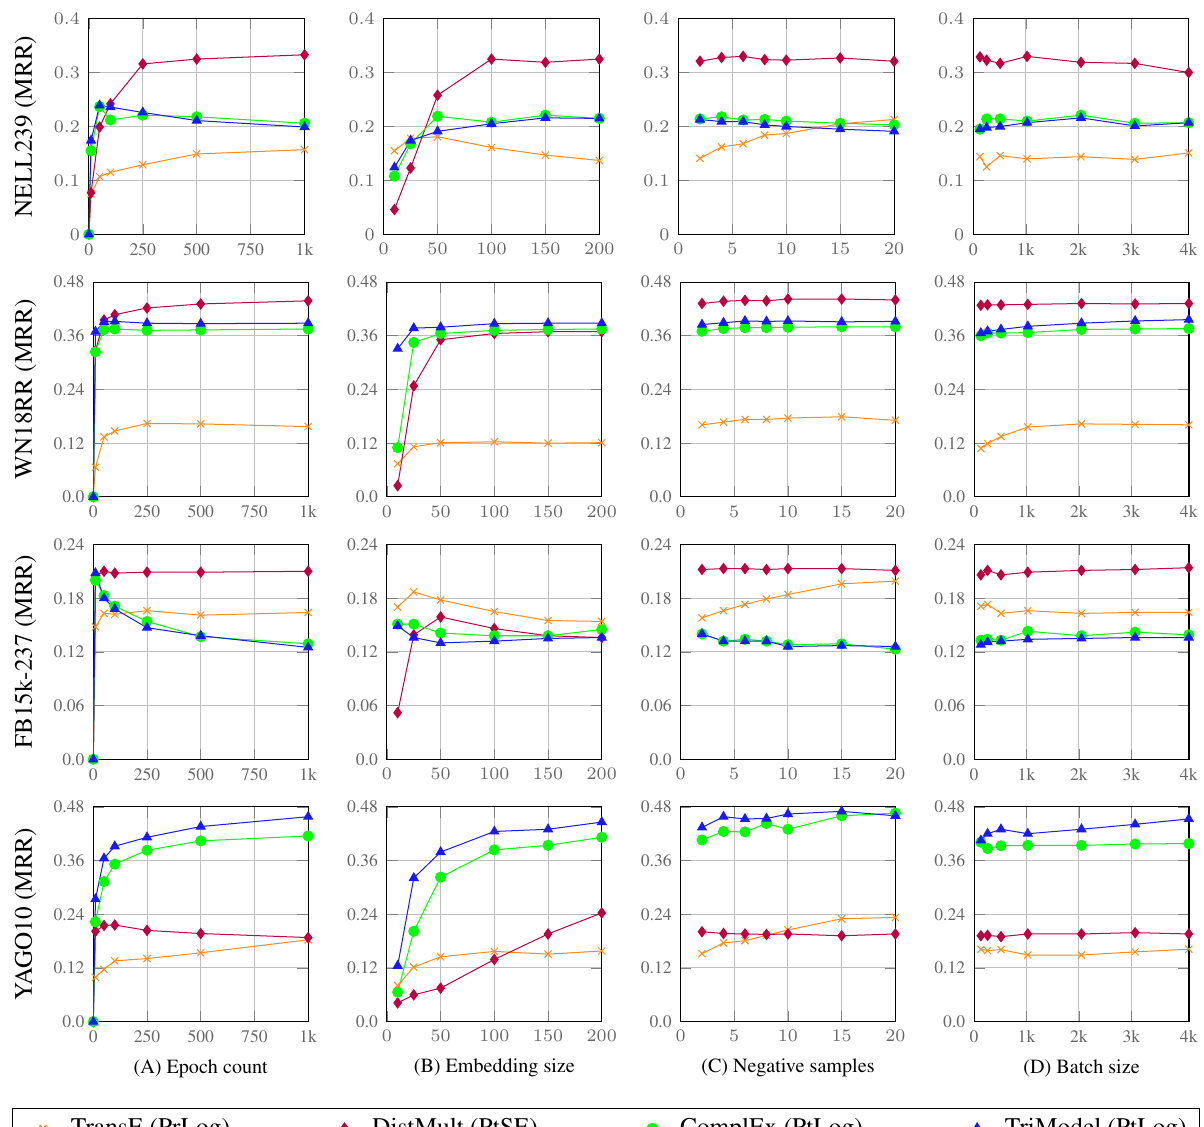
Figure 6. A set of plots which describe the e ff ects of training hyperparameters of KGE models and their e ff ects on the models’ accuracy in terms of MRR on di ff erent benchmarking datasets. The base hyperparameters for our experiments are: embedding size ( k = 150), negative samples per positive ( n = 2), batch size ( b = 2048), number of epochs ( e = 500), optimizer (AMSgrad), learning rate (lr =